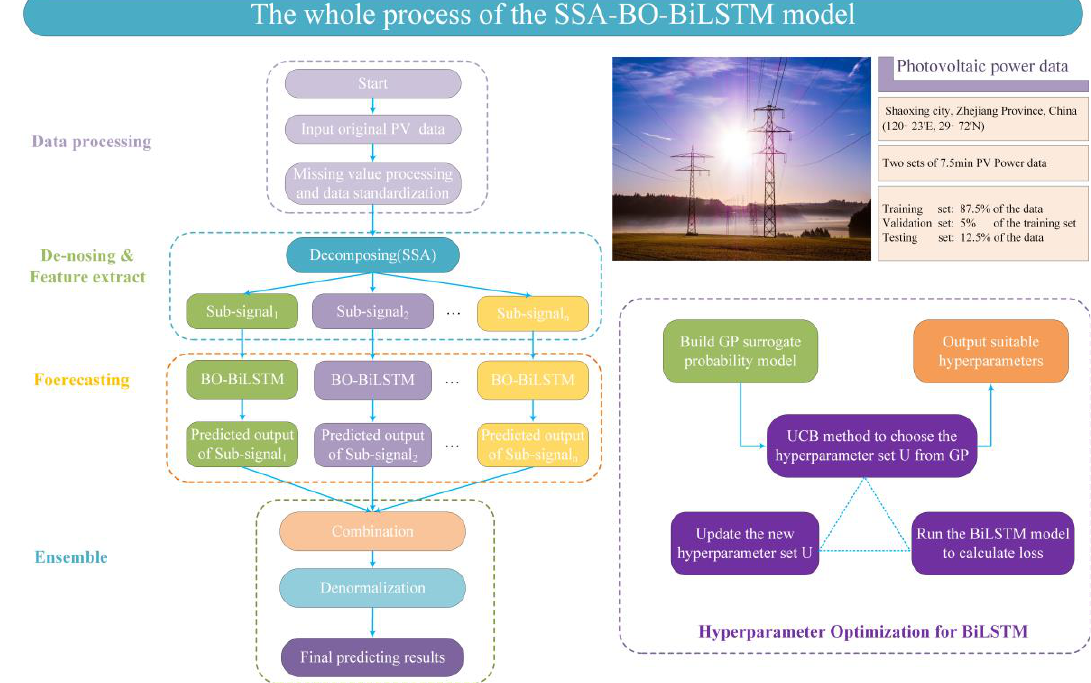
Figure 3. Illustration of the SSA-BO-BiLSTM prediction strategy.